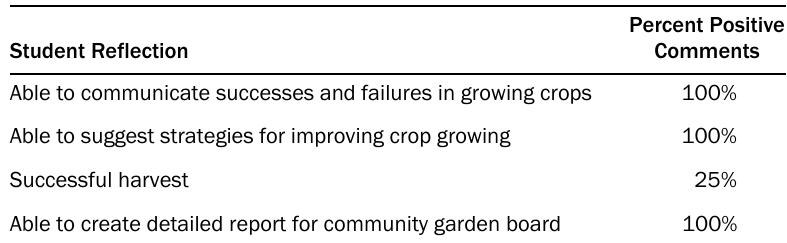
Table 2a. Results of Botany Student Reflections (n =